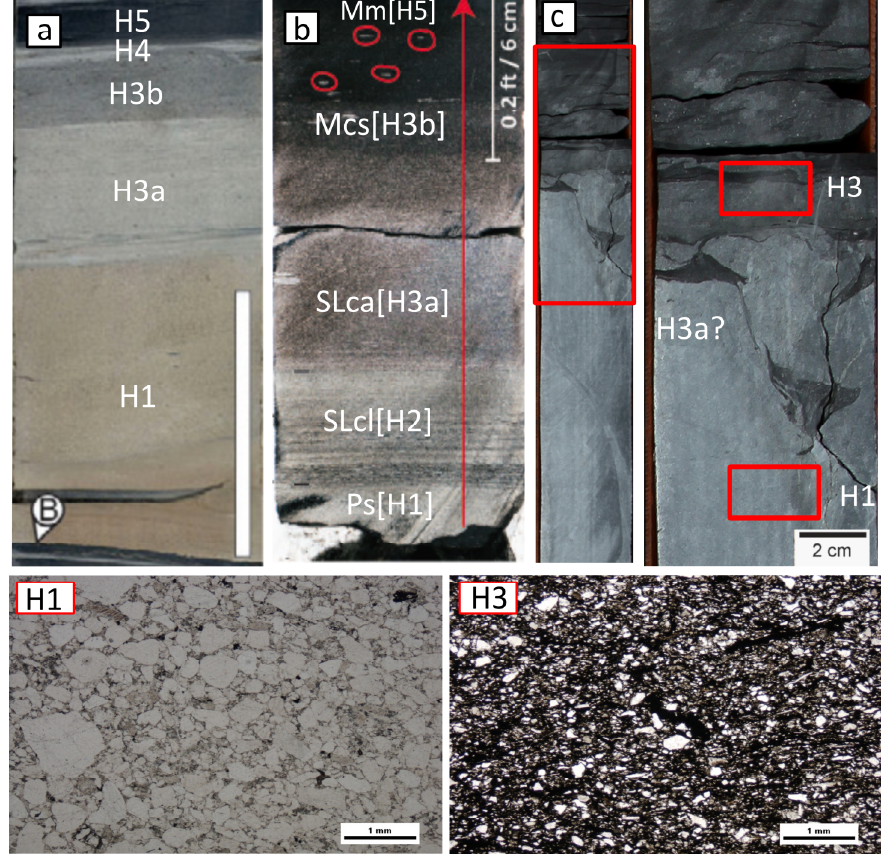
Figure 4. Core photographs showing; ( a ) a type IV hybrid event bed with organic-rich H3b and H5 divisions from the Palaeogene Gulf of Mexico [48]. Reprinted/adapted with permission from Ref. [48], 2012, GSA; ( b ) a mixed siliciclastic–carbonate hybrid event bed with organic-rich muddy H3b and H5 divisions from the Wolfcamp A Formation in the Permian Basin, USA [8]. Re- printed/adapted with permission from Ref. [9], 2019, AAPG; and ( c ) a hybrid event bed with organ- ically-lean H1 and organic-rich H3 divisions from the Ross Sandstone Formation, western Ireland. Organic matter is preferentially segregated in H3 divisions in hybrid event beds. Red rectangles on the core photographs show the location of plug samples.